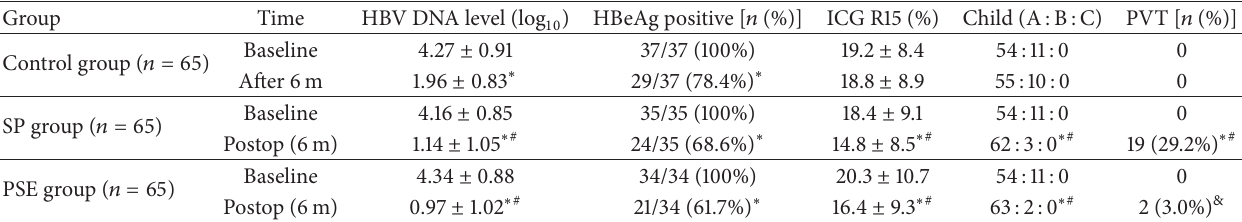
Table 3: Short-term outcomes (6m) among the three groups.